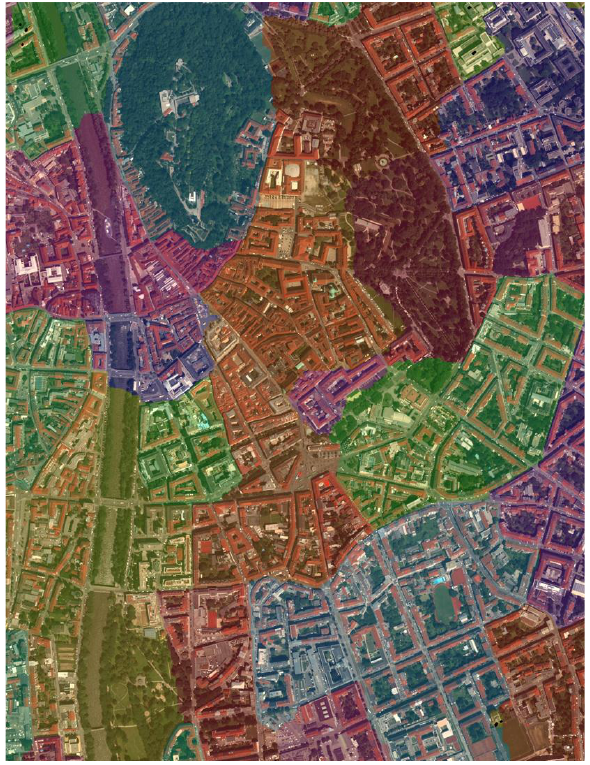
Figure 3 Example for a contribution mask being color coded.